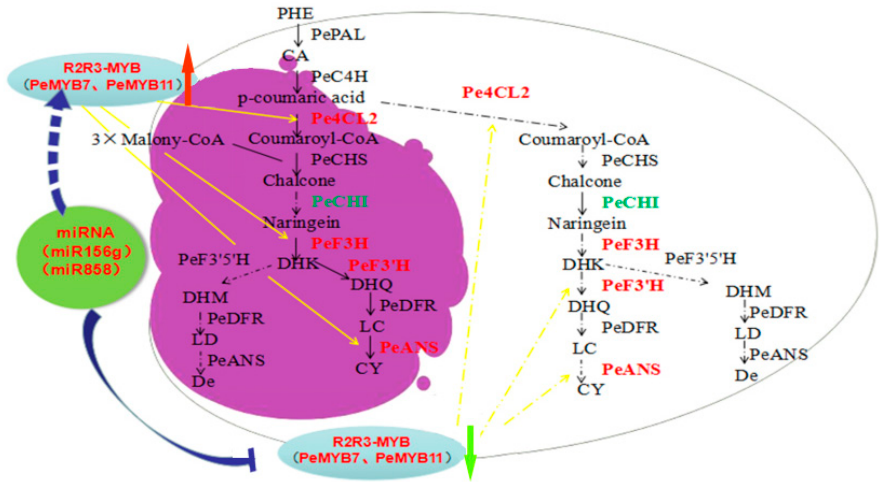
Figure 9. A proposed model summarizing of spot formation pattern in Phalaenopsis ‘Panda’ sepal. The purple segment illustrates the accumulation of anthocyanidin in spot area of ‘Panda’. MIR156g, MIR858 target on key regulate genes PeMYB7 and PeMYB11 , suppressed the transcript level of Pe4CL2 , PeF3H , PeF3 ′ H , PeANS and resulted in reduced anthocyanidin production in the non-spot area, while relatively lower expression levels of MIR156g and MIR858 and high levels of transcription of these genes in spot area cause accumulation of anthocyanidin. The black dashed arrows represent low levels of transcription, while the black solid-line arrows represent high levels of transcription. The yellow solid-line arrows represent promoting transcription, while yellow dashed arrow represent lack of promotion function. The blue bold solid-line T-arrow represents interfering transcription, while blue bold dashed arrow represents lack of interference function. The red bold arrow represents upregulation, and the green bold arrow represents downregulation. DHK, dihydrokaempferol; DHQ, dihydroquercetin; DHM, dihydromyricetin; LC, leucocyanidin; LD, leucodelphinidin; Cy, cyanidin; De, delphinidin.